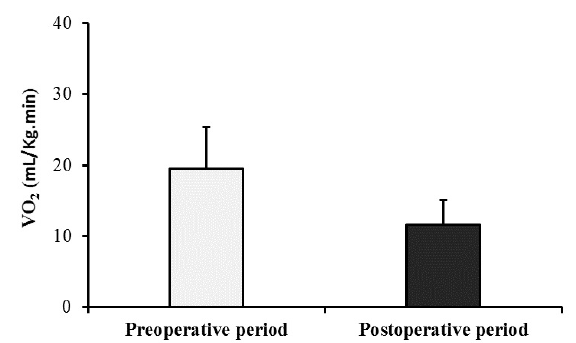
Figure 3 - Patients’ pre- and postoperative oxygen uptake as estimated by the Duke Activity Status